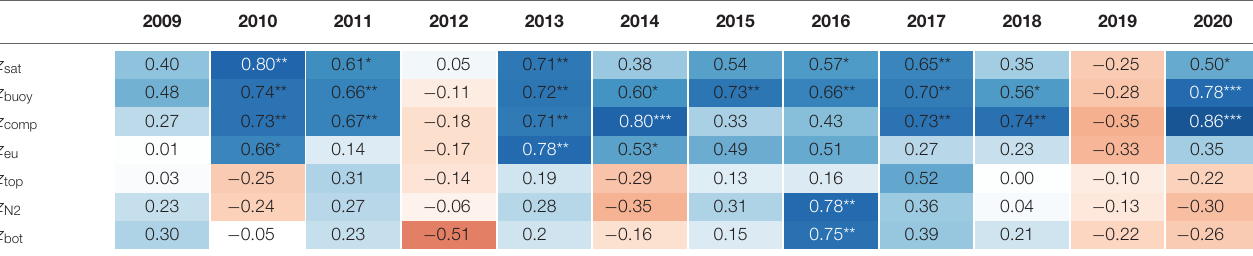
TABLE 1 | Correlation coefficients (Spearman’s correlation) for the depth of Planktothrix rubescens Chl a maxima versus the depth for three intrinsic light conditions, the upper and lower boundary of the metalimnion, and the depth of maximal